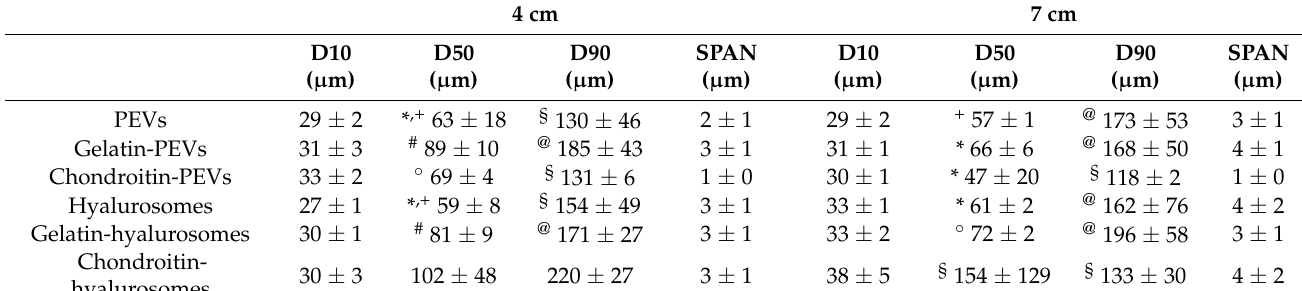
Table 2. Average diameter of droplets generated by spraying C. halicacabum extract-loaded PEVs, gelatin-PEVs, chon- droitin-PEVs, hyalurosomes, gelatin-hyalurosomes, and chondroitin-hyalurosomes, and measured using Spraytec ® . Mean values ± standard deviations of three measurements were reported. The same symbol (*, § , + , # , °, @ ) indicates the same value.